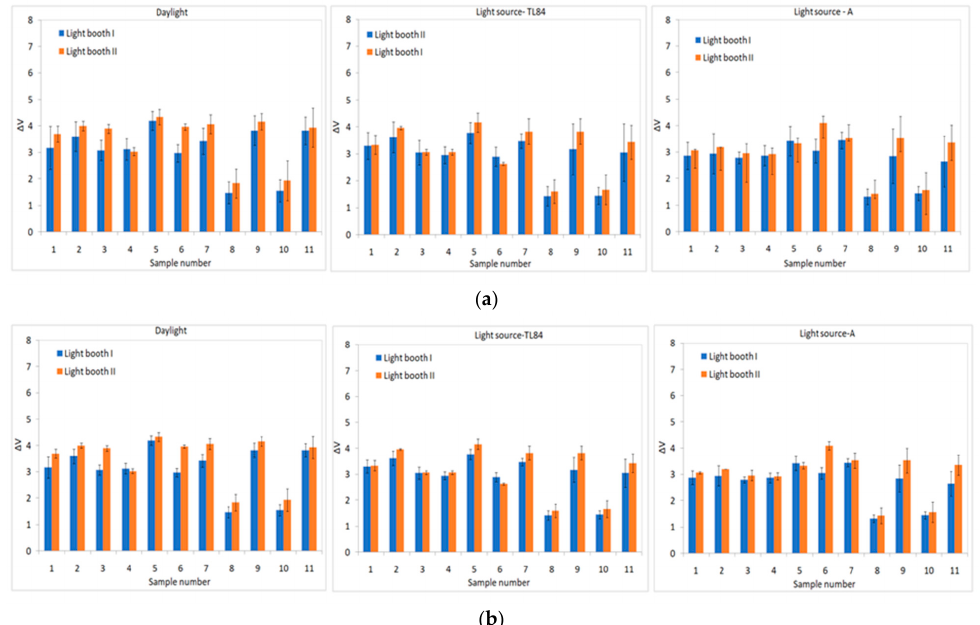
Figure 7. Average inter-observer variability of all metameric pairs under each light source with ( a ) standard deviation (SD) bars; ( b ) standard error of the mean (SEM). In the figure, BLED65, BLED40, and BLED27 represent the light sources with nominal CCT 6500 K, 4000 K, and 2700 K, respectively for light booth I; and Daylight (Simulator D65), TL84 (Tri-band fluorescent tube), and A (Tungsten lamp) represent the light sources with nominal CCT 6500 K, 4000 K, and 2700 K respectively, for light booth II. Table 2. Mean CIE L*a*b* values for different light sources of the two booths. In the table, BLED65, BLED40, and BLED27 represents the light sources with nominal CCT 6500 K, 4000 K, and 2700 K respectively for light booth I; and Daylight (Simulator D65), TL84 (Tri-band fluorescent tube), and A (Tungsten lamp) represent the light sources with nominal CCT 6500 K, 4000 K, and 2700 K, respectively for light booth